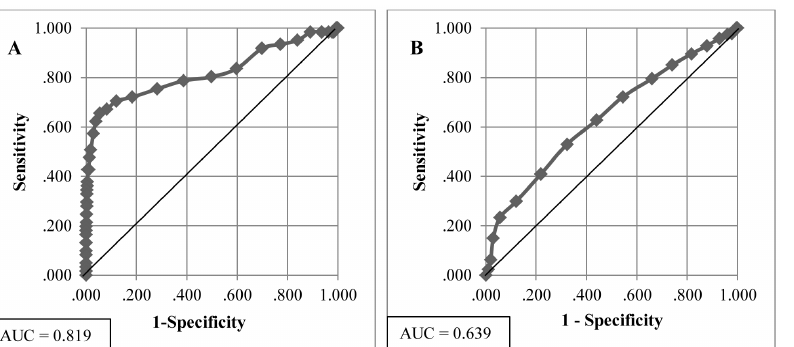
Figure 1. HbA 1c receiver operating characteristic (ROC) curves for diabetes (A) and prediabetes (B) using FPG as a reference. AUC: area under the receiver operating characteristic curve.